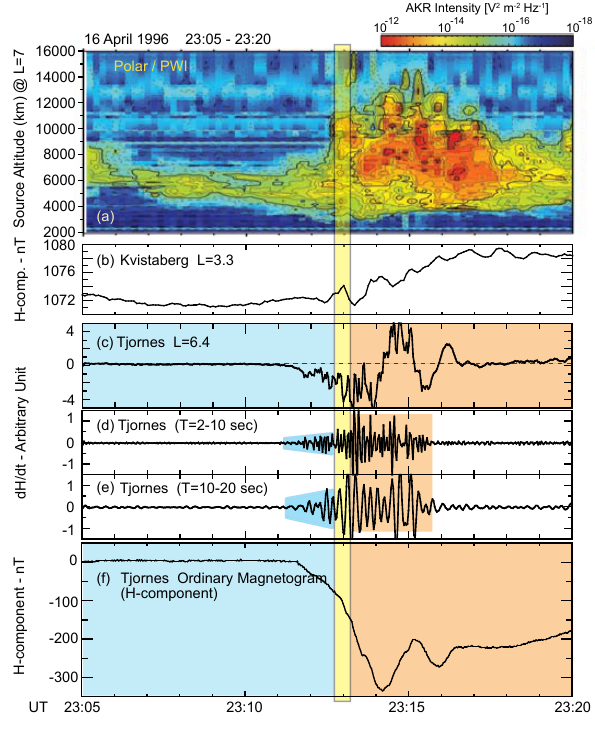
Fig. 2 Fig. 2. Vertical evolution of AKR during substorm on 16 April 1996 and related geomagnetic variations. (a) a − t diagram of AKR from Polar/PWI; AKR breakup (from 7000 to 12000km) occurred about 23:13UT (vertical rectangle) above pre-existing low-altitude AKR (from 4000 to 6000km). (b) H-component of geomagnetic field at mid-latitude station, Kvistaberg ( L =3.3); Pi2 pulsation started al- most simultaneously with AKR breakup. (c) dH/dt record at auroral station, Tjornes ( L =6.4); high-latitude Pi2 pulsation started around 23:10UT. (d) and (e) band-passed components of Tjornes pulsa- tion; pass-bands were 2–10 and 10–20s, respectively. (f) Ordinary magnetogram at